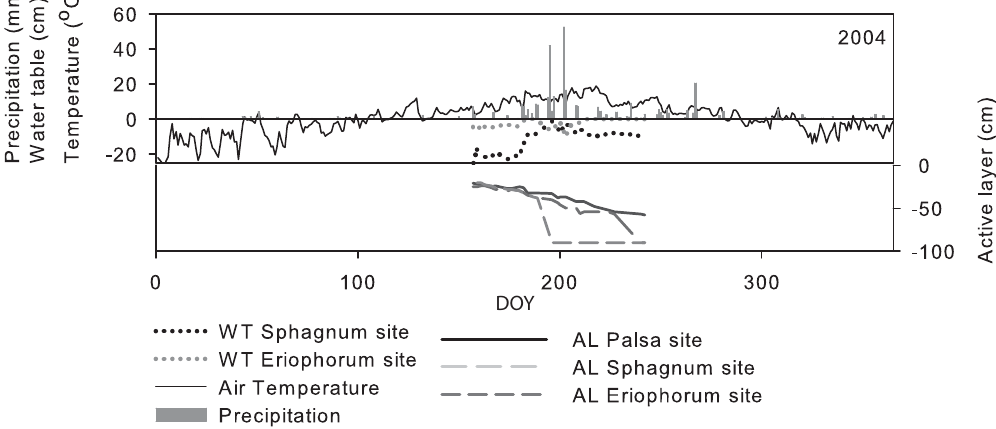
Fig. 2. One year of environmental parameters of water table (WT) and active layer (AL) show the differences in moisture and permafrost regimes at the three sites (Palsa, Sphagnum and Eriophorum ) in the summer season. The annual temperature curve and green season precipitation data were collected at Abisko Scientific Research Station. DOY on the x axis stands for day of year.